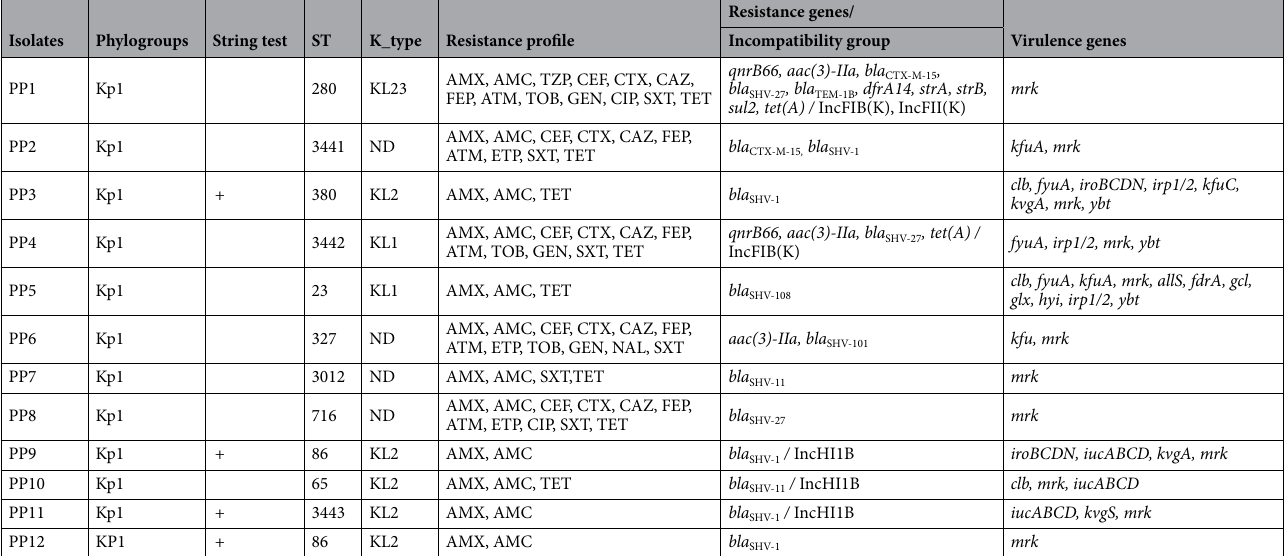
Table 2. MLST profiles, cps K-types, resistance profile, resistance genes and virulence genes. ND not